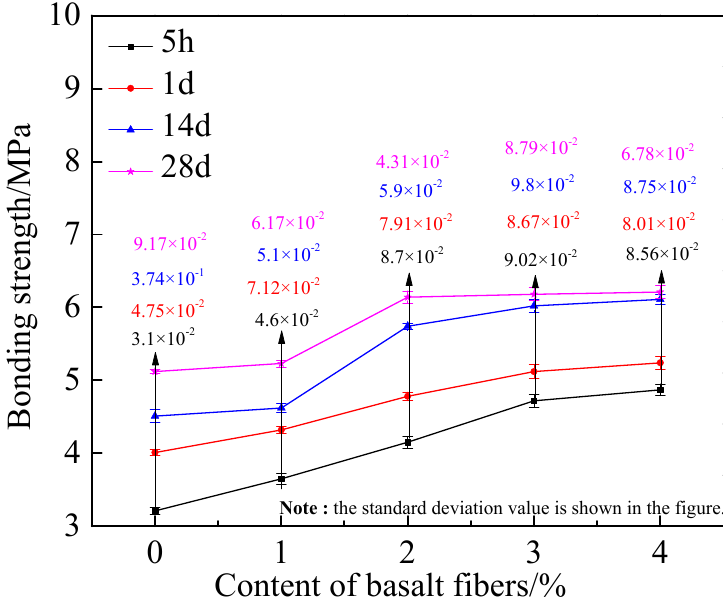
Figure 4. Bonding strength of cement mortar repaired by SAC-RPC.